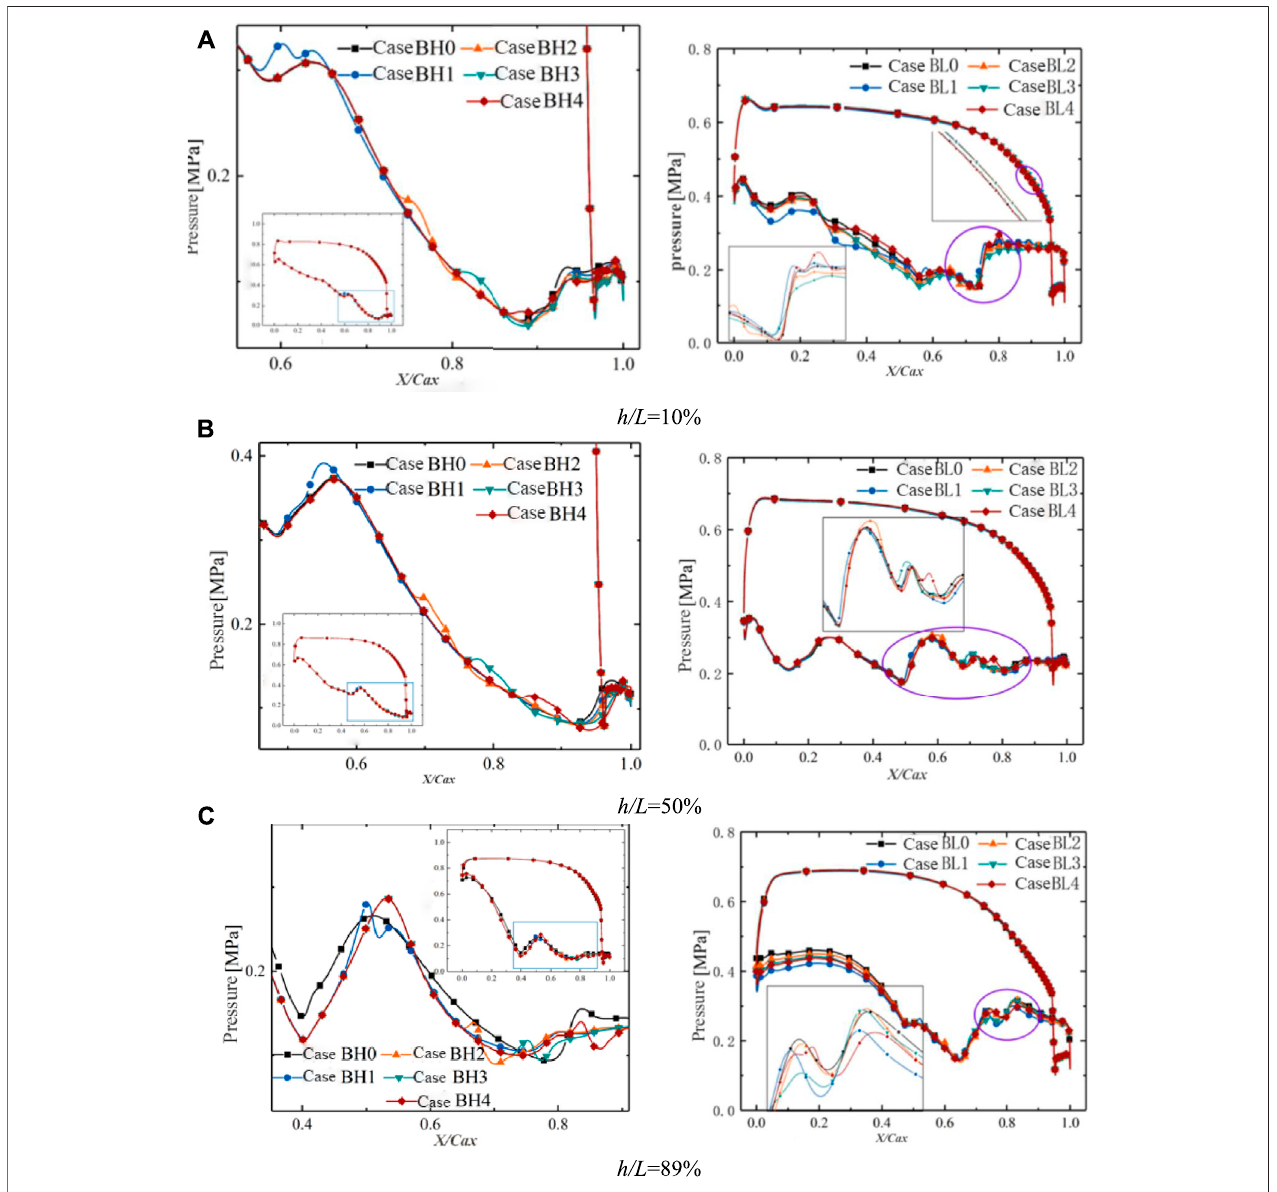
FIGURE 4 | The pressure distribution in different height sections for two degrees of reaction (DORs). (A) h/L = 10%, (B) h/L = 50%, and (C) h/L = 89%.